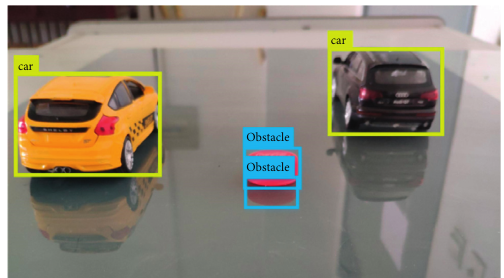
Figure 19: VM identification effect diagram.